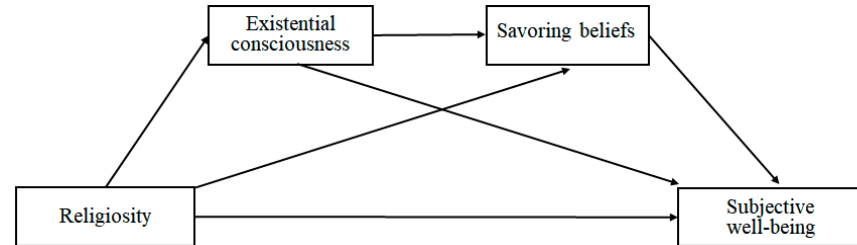
Figure 1. Double sequential mediation model.